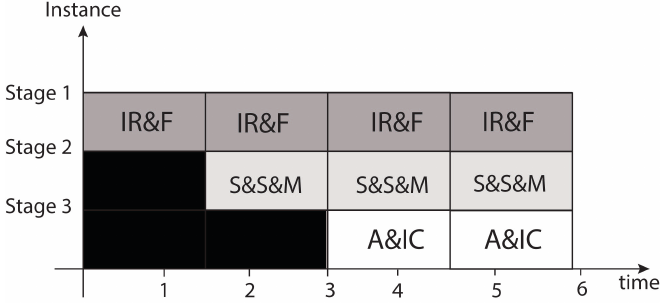
Figure 11. Temporal diagram of the 3-stage pipeline for the AES